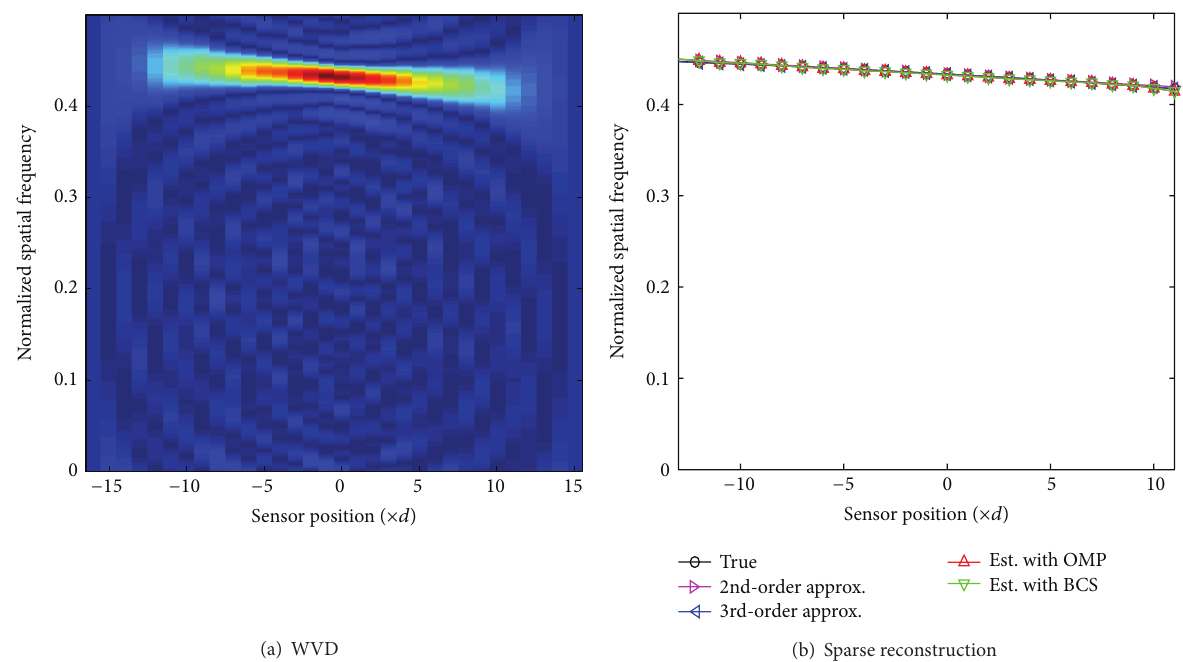
Figure 4: Near-field source location estimation using the ULA ( 𝑟 1 = 1000 m, 𝜃 1 = 30 ∘